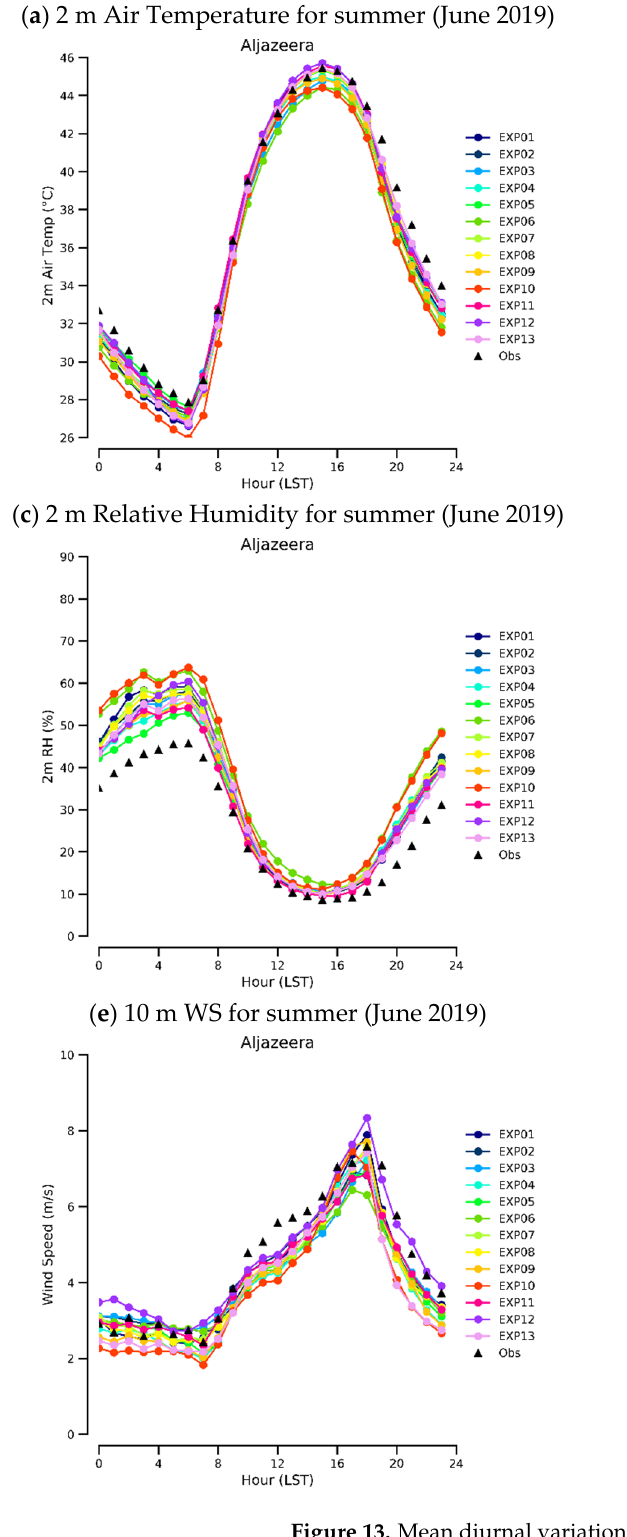
Figure 13. Mean diurnal variations for T2, RH, and WS calculated at Aljazeera station calculated for June and January 2019. The curve in black color shows the observation, while the others depict the different model simulations. Table 6. Statistical metrics calculated for June 2019 hourly data at Aljazeera station.